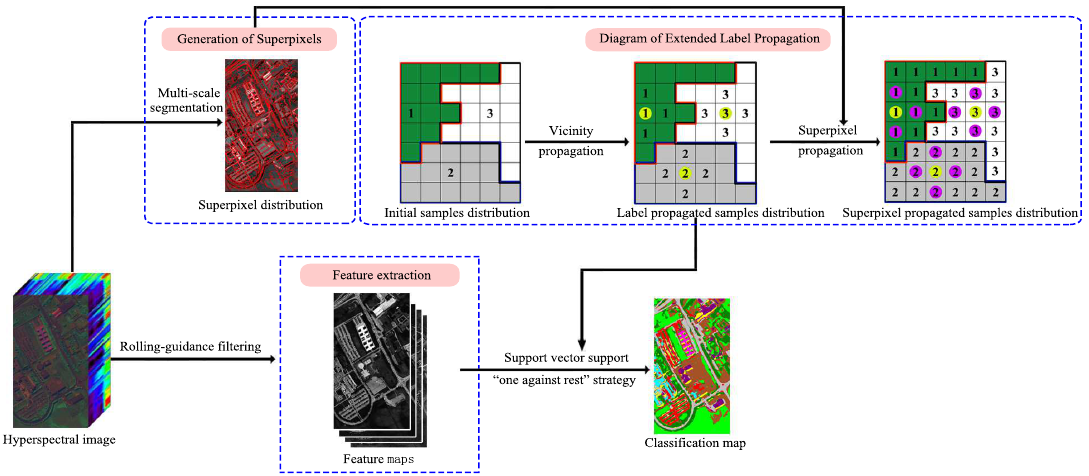
Figure 2. Schematic of the proposed semi-supervised classification method of hyperspectral images based on extended label propagation and rolling guidance